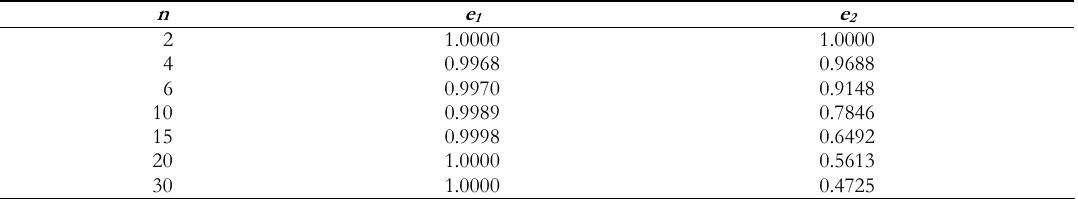
and e for k = 1 2